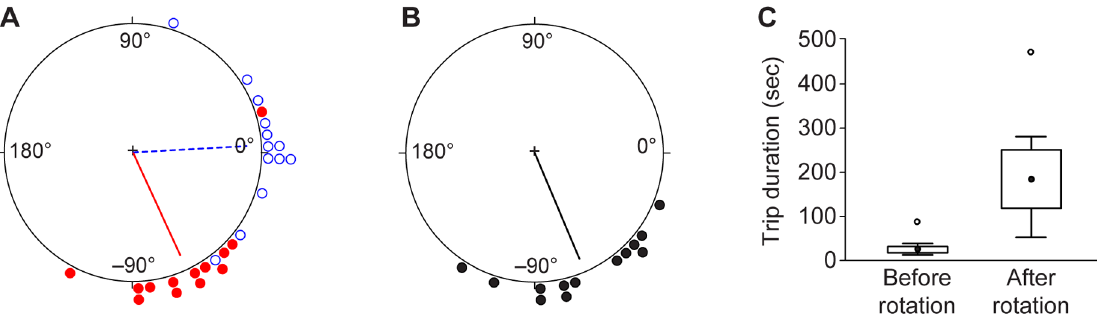
Figure 7. Rotation of visual cues strongly affects orientation by emigrating ants. A) The last trip before rotation (dashed blue line and open blue circles) was highly directed (Rayleigh test: r=0.88, p=6 6 10 2 7 ) and deviated only 3 u from the direction of the new nest (0 u ). After rotation (solid red line and closed red circles), average heading remained highly directed (Rayleigh test: r=0.88, p=8 6 10 2 7 ) but shifted to 65 u clockwise from the nest heading (Watson’s two-sample test: U 2 =0.3883, p , 0.001, n=13). B) The average change in heading by each ant was 67 u (r=0.89, p=5 6 10 2 7 ) and the mean change significantly differed from zero (Hotelling test: F 2, 11 =35.2, p=2 6 10 2 5 ). C) The duration of journeys from the old to the new nest increased after rotation of visual cues (Wilcoxon paired ranks test: V=2, n=11, p=0.0029). See Figure 2 for box plot details.